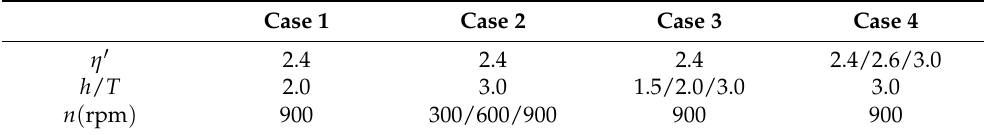
Table 2. Cases of numerical simulations.